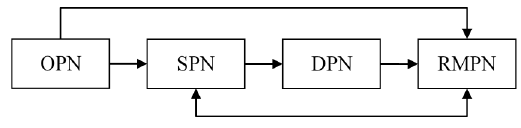
Figure 3. Connections between PNs.